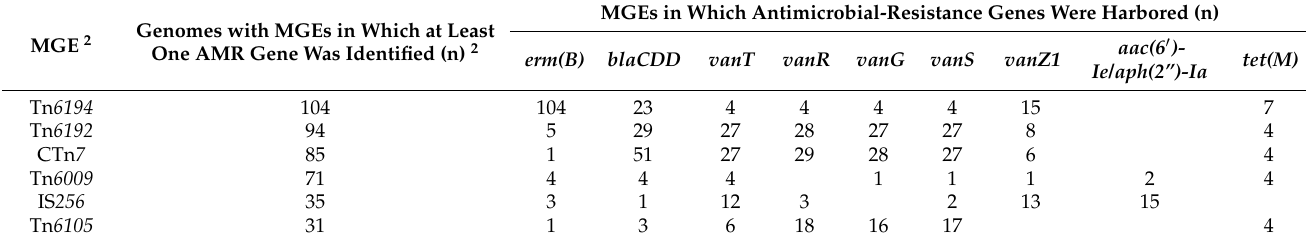
Table 3. Antimicrobial-resistance genes harbored in mobile genetic elements 1 . MGEs in Which Antimicrobial-Resistance Genes Were Harbored Genomes with MGEs in Which at Least MGE 2 One AMR Gene Was Identified (n) 2